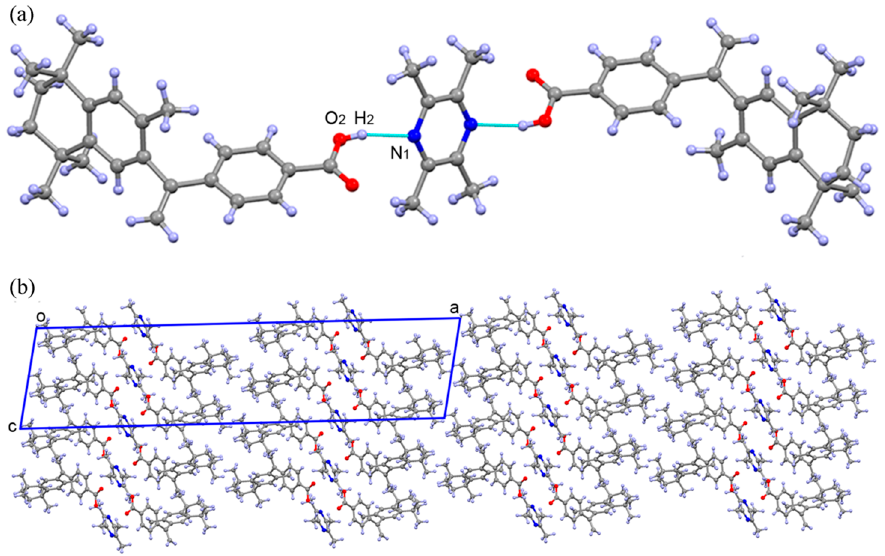
Figure 3. Single crystal X-ray diffraction of 2bexarotene-ligustrazinewas (2BEX-LIG) drawn with Mercury 2.4, where the red balls are O atoms, blue balls are N atoms, gray balls are C atoms, and white balls are H atoms: the blue squares were the asymmetric unit of 2BEX-LIG along the a, b, and c axes. ( a ) Hydrogen bond between O 2 -H 2 ··· N 1 ; ( b ) a layer structure along the b axis.